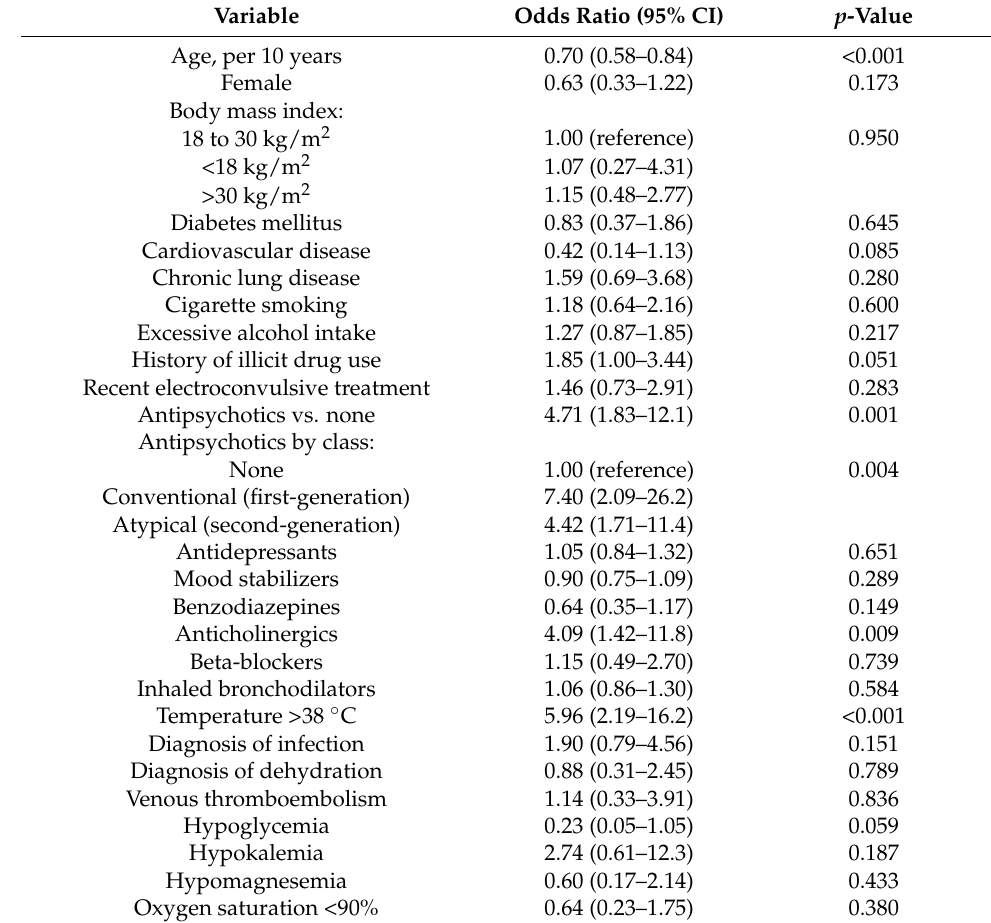
Table 4. Univariable logistic regression analysis of tachycardia.